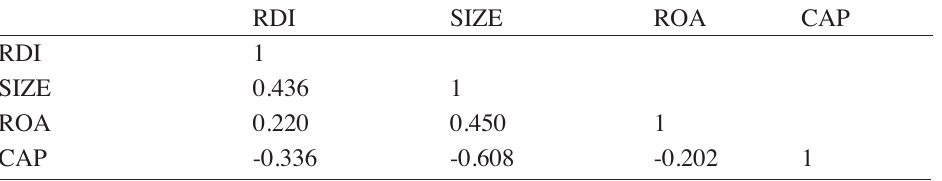
Table 2: Pearson Correlation Coefficient Matrix RDI SIZE ROA CAP